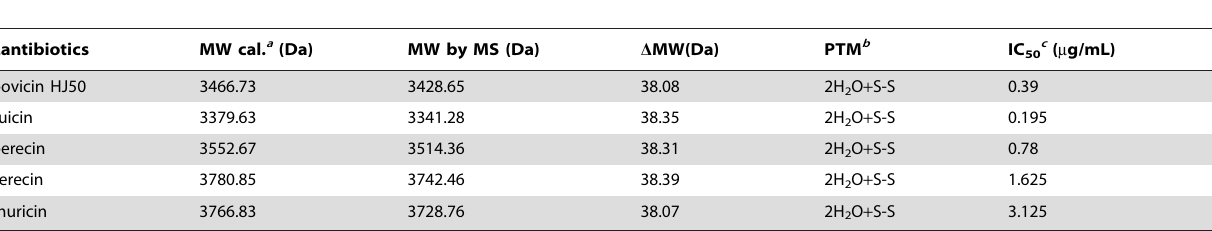
Table 1. MS analysis and IC 50 determination of bovicin HJ50-like lantibiotics.